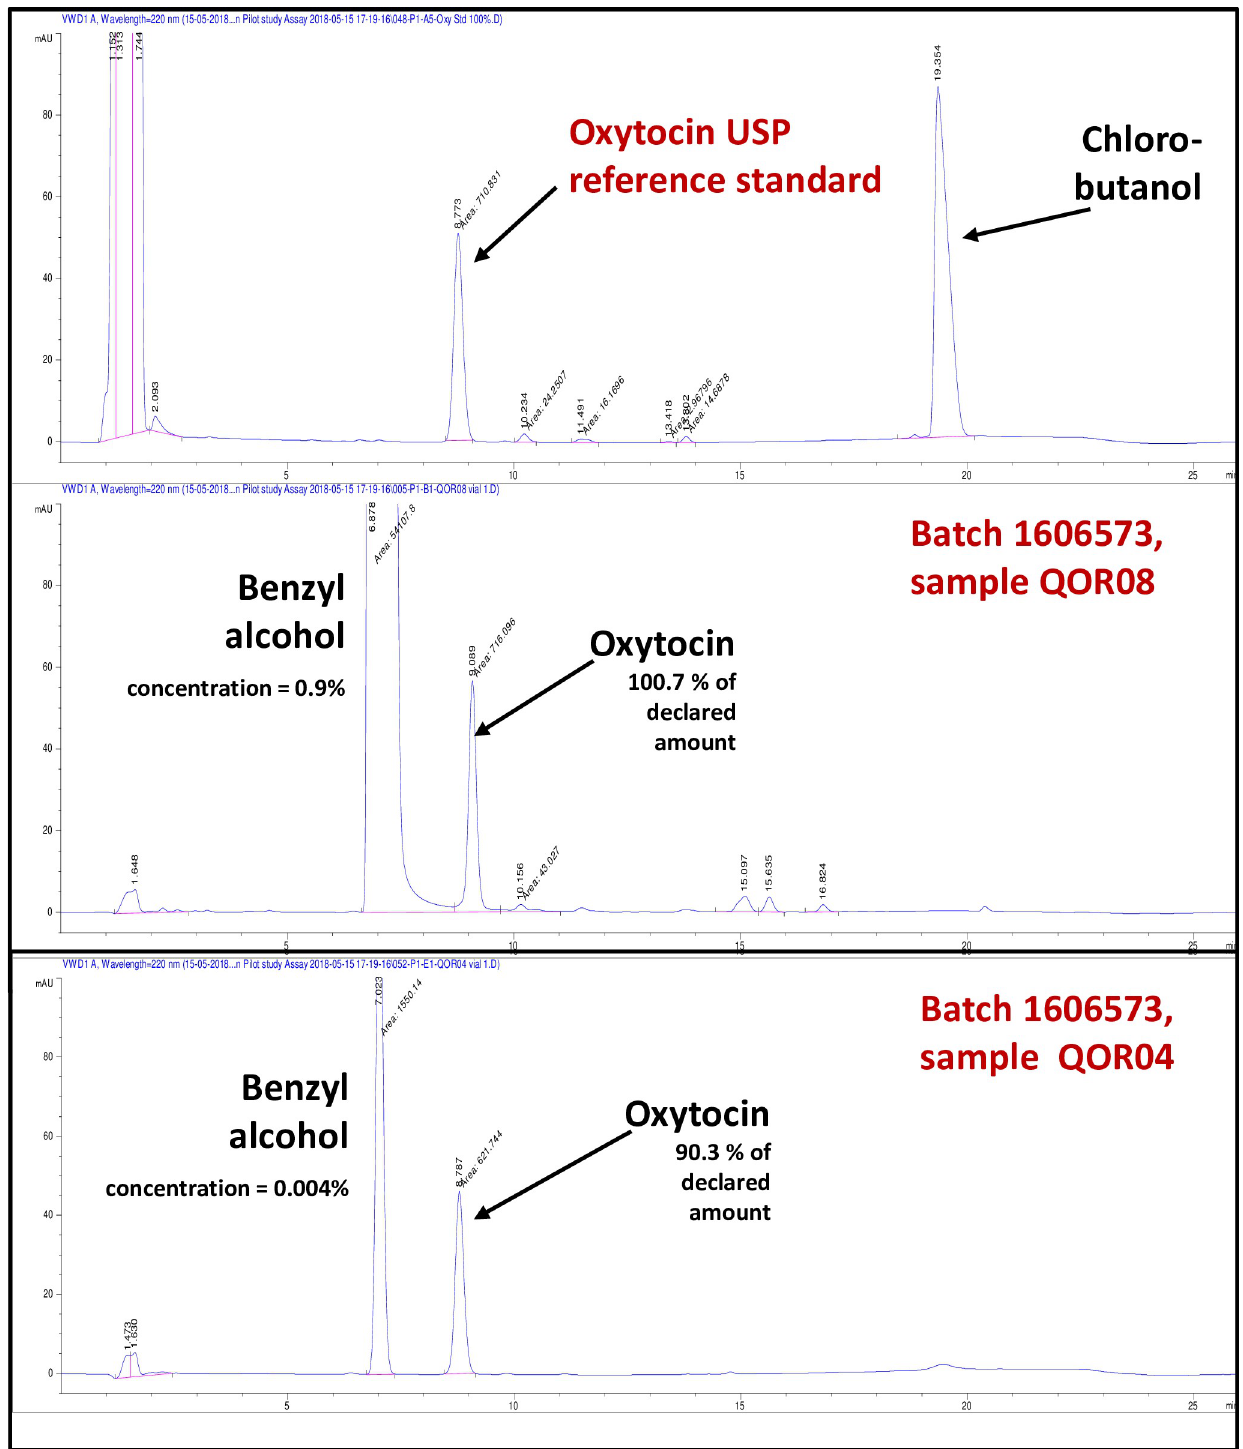
Fig 4. HPLC detection of the undeclared preservative benzyl alcohol, present in different concentrations in oxytocin samples of the same batch, stated to be manufactured by Jiangxi Xierkangtai Pharmaceuticals Co. Ltd (China).